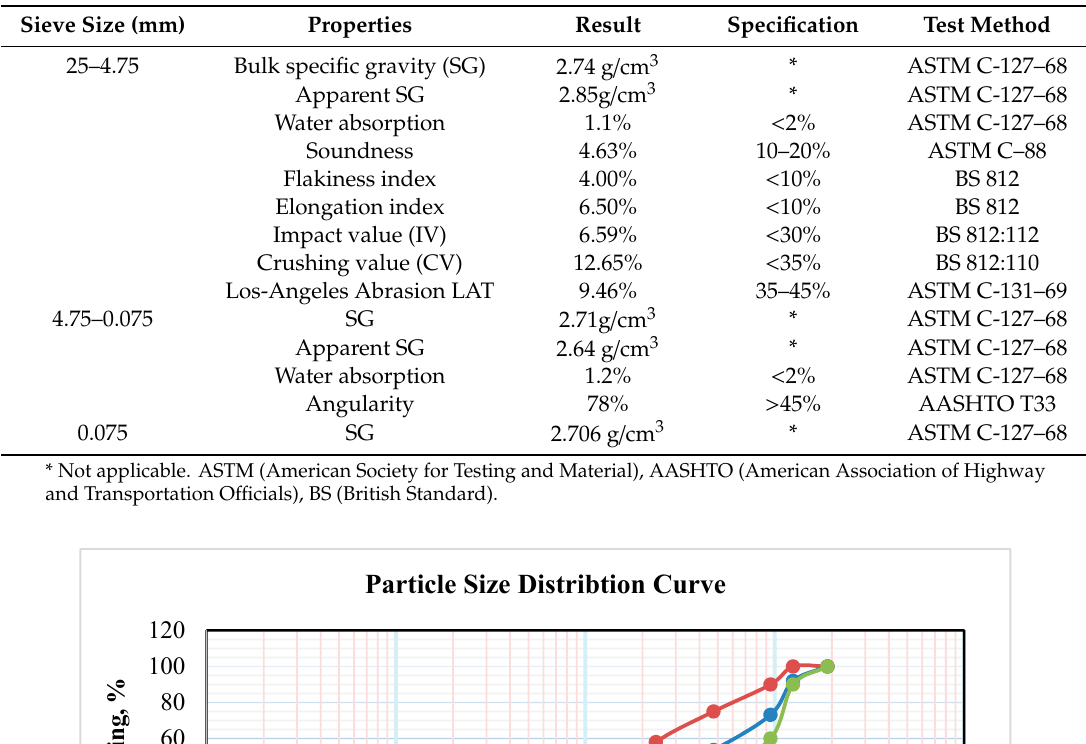
Table 2. Asphalt binder sample range matrix and definition.